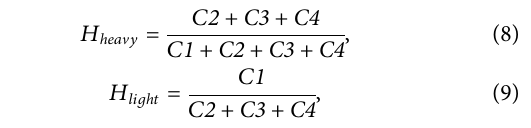
Frontiers in Energy Research |